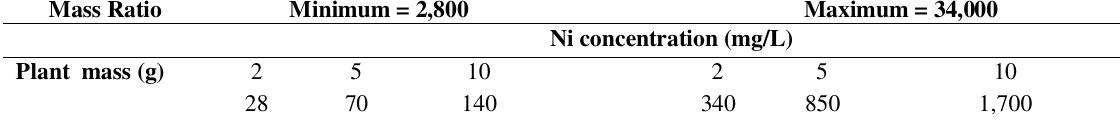
Plant mass planted in each aquarium with respect to Ni concentration